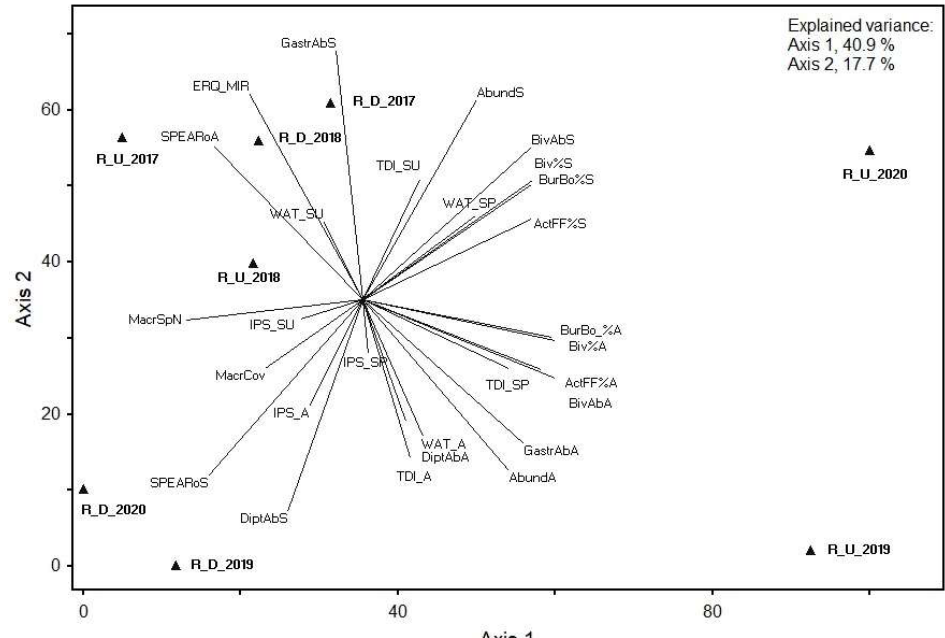
Figure 4. PCA showing the relationship between phytobenthos, macrophyte, and selected macroin- vertebrate metrics at two Rusinupe stream sites in 2017–2020. Abbreviations: Sampling site code: R,